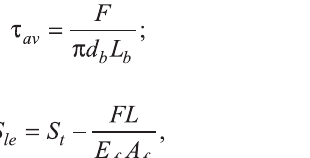
Table 1. Configuration of tested specimens with CFRP and GFRP bars Specimen with CFRP